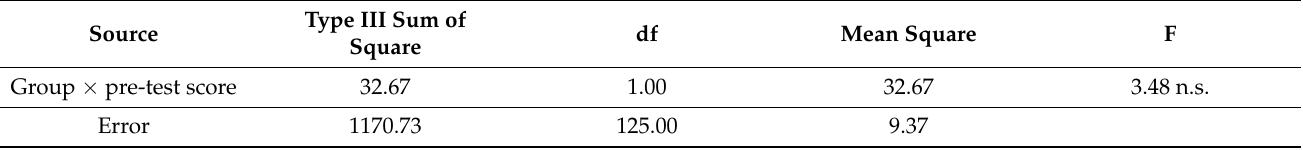
Table 3. The test of homogeneity regression coefficient within groups.